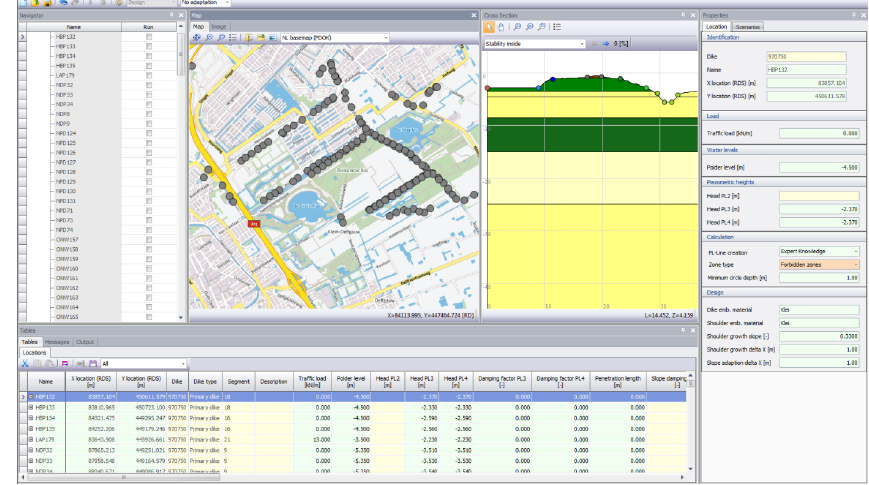
Figure 2. Cross-sections in DAM.